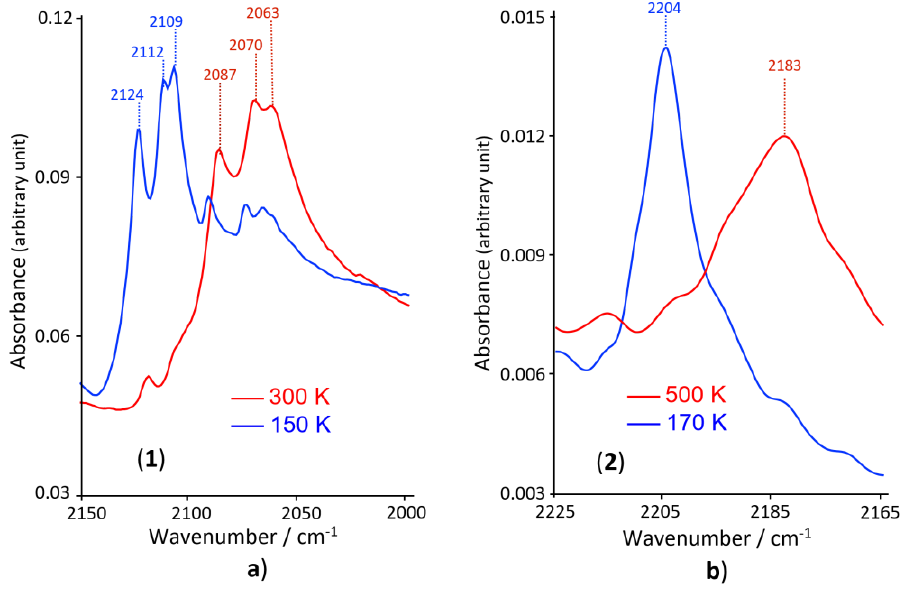
Figure 3. Infrared spectra for compounds 1 ( a ) and 2 ( b ) in the 2150–2200 cm − 1 region, showing the principal bands that are temperature sensitive.